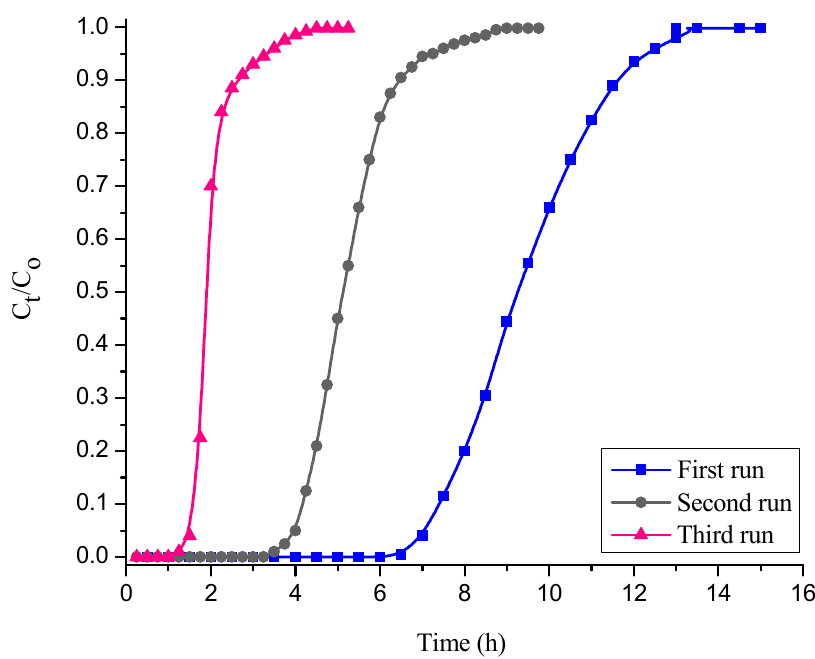
Figure 5. BTCs for decolorization of CR dye by sodium silicate gel-immobilized NNLP adsorbent in various runs. (Initial pH: 6; flow rate: 1 mL min − 1 ; inlet dye concentration: 15 mg L − 1 ; temperature: